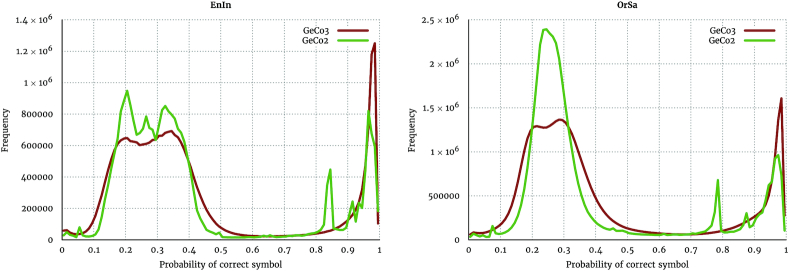
Comparison of histograms using the EnIn (Entamoeba invadens) and OrSa (Oryza sativa) genome sequences and GeCo2 and GeCo3 as data compressors.